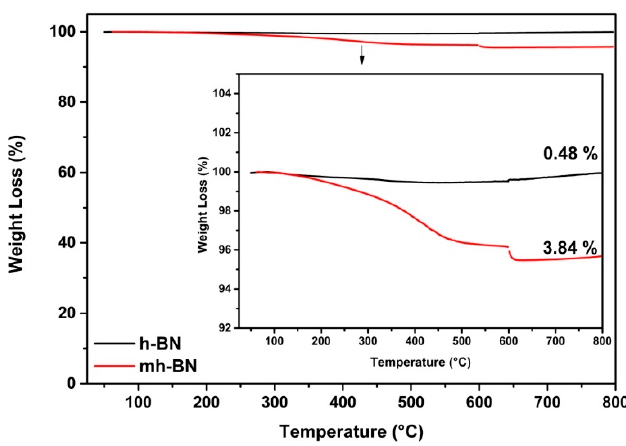
Figure 3. Thermogravimetric analysis (TGA) thermograms of unmodified (h-BN) and plasma-modified (mh-BN) nanoparticles.